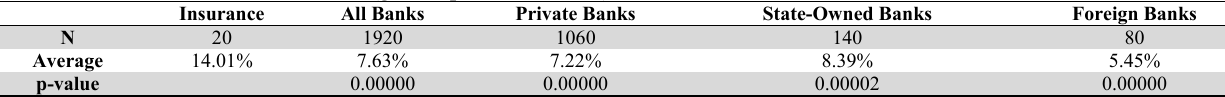
Life Insurance PM versus Bank NIM (gross up with 25% tax) Insurance All Banks Private